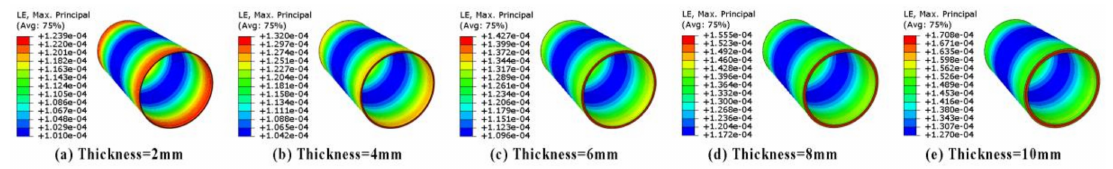
Figure 11. Influence of the thickness on stress of variable-stiffness composite cylinders.